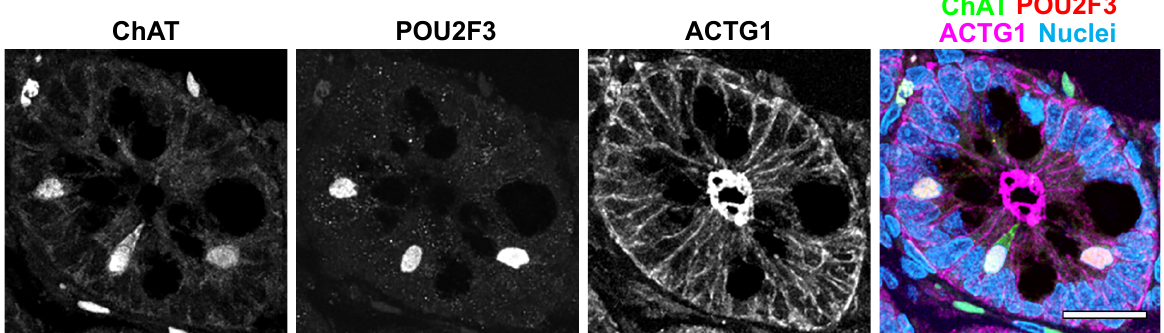
Figure 3. Immunostaining for human intestinal tuft cells. Both ChAT and POU2F3 are detected in tuft cells in jejunum paraffin sections. Scale bar: 20 µm.